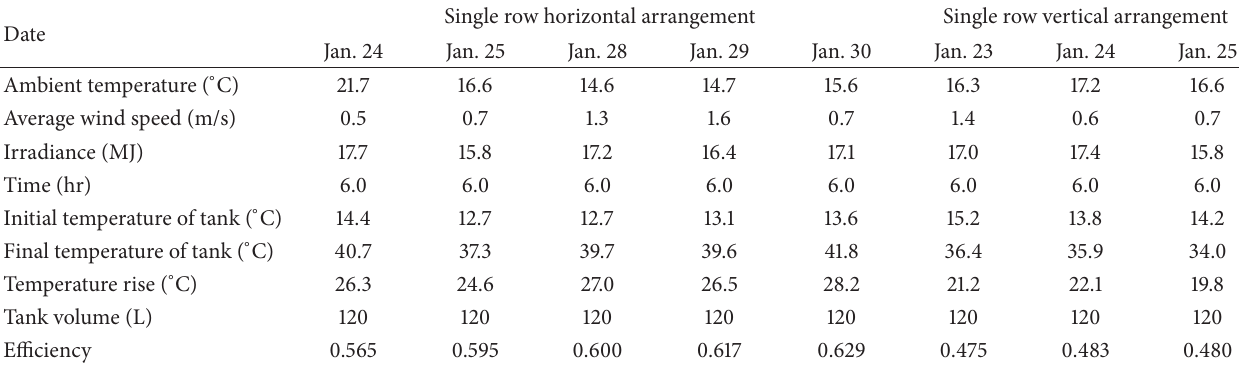
Table 4: Performance of all-glass evacuated tubular collector at a surface slope angle of 90 ∘ .